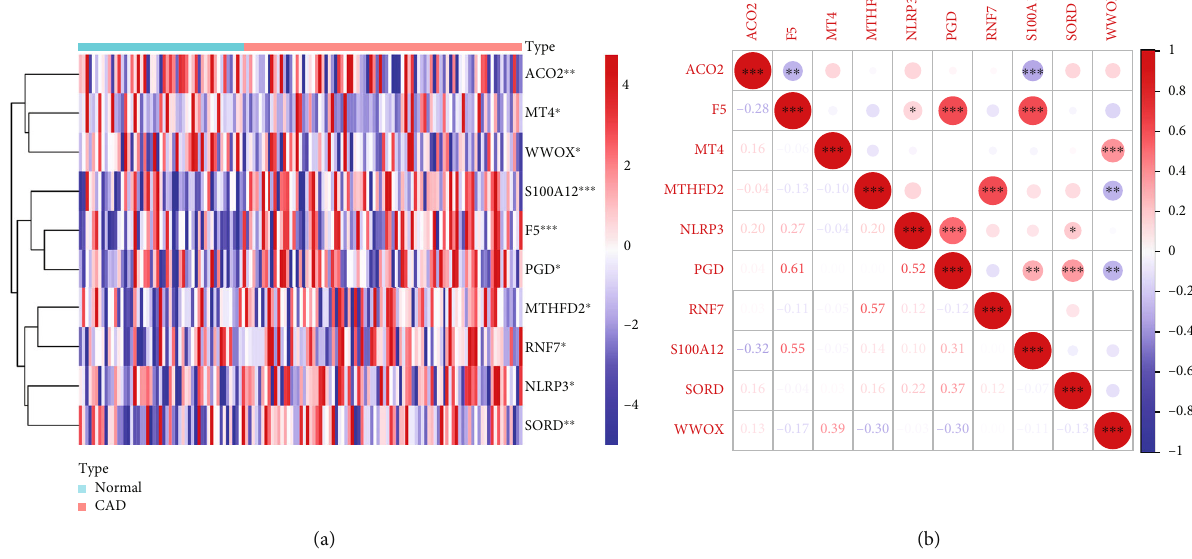
Figure 1: Identi fi ed 10 DE-CRGs in the GSE20680 cohort by di ff erential expression analysis. (a) Heat map of 10 DE-CRGs in CAD patients and normal samples. Red represents high expression while blue represents low expression. (b) Spearman ’ s correlation analyses between every two DE-CRGs. ∗ p < 0 : 05 , ∗∗ p < 0 : 01 , and ∗∗∗ p < 0 : 001 vs. the normal